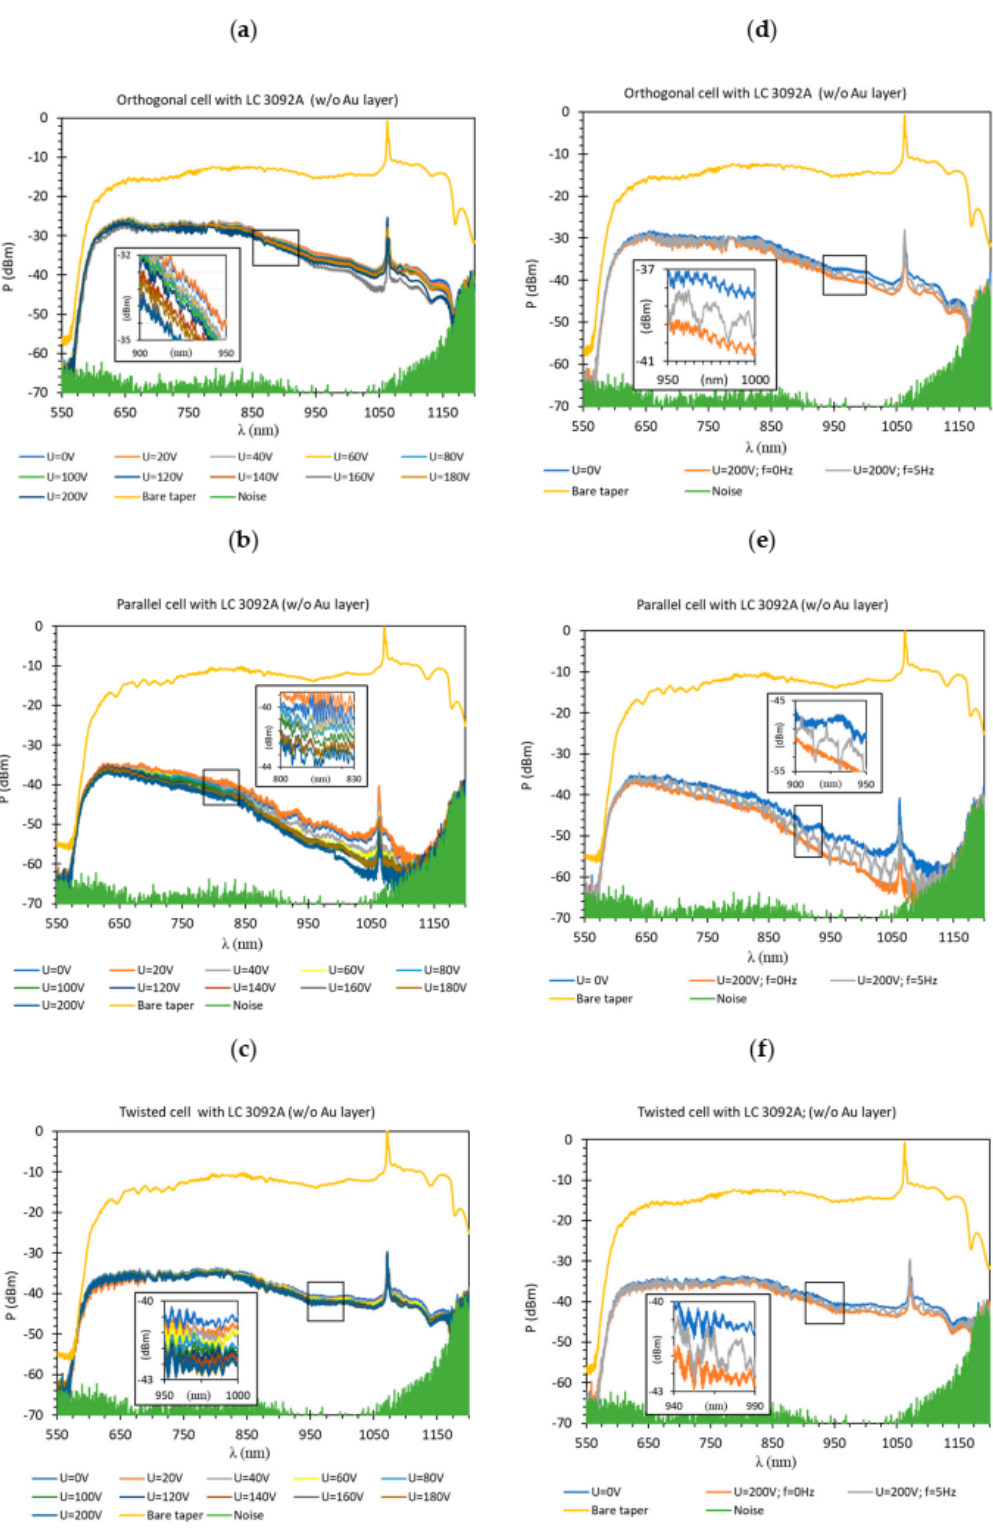
Figure 7. The spectra obtained for the LC cell without metallic layers ( a ) orthogonal; ( b ) parallel; and ( c ) twisted, under steering voltage U in the range of 0–200 V. Spectra obtained for: ( d ) orthogonal; ( e ) parallel; and ( f ) twisted cell for the steering voltage U = 0 and 200 V without and with a 100% depth AM, at frequency f = 5